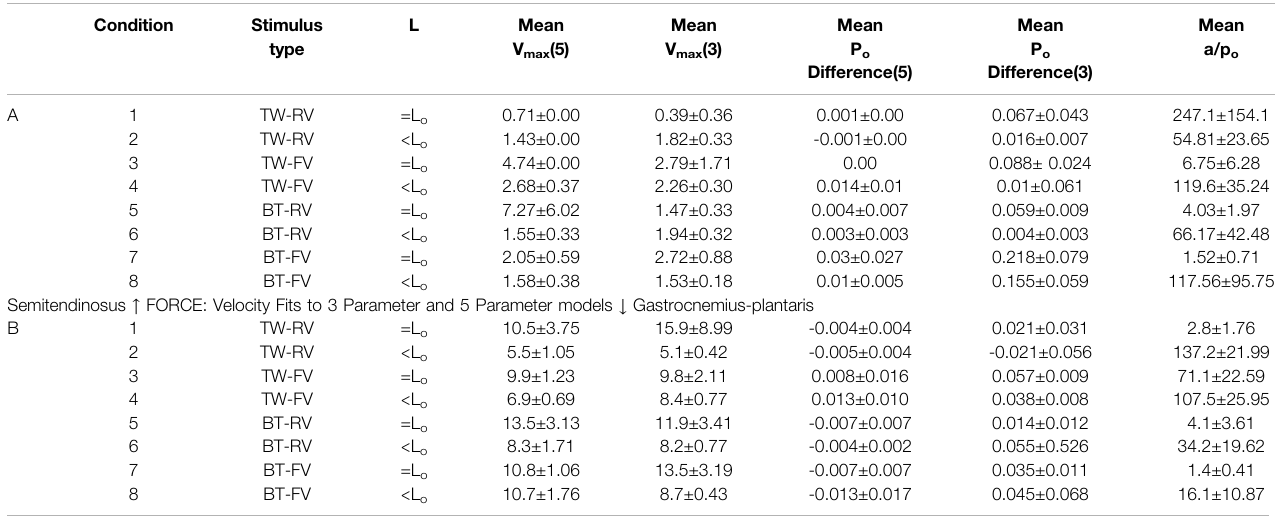
TABLE 1 | Parameters for the least squares fi t for Eqs 1A , 2 for semitendinosus (top) and gastrocnemius-plantaris (bottom).